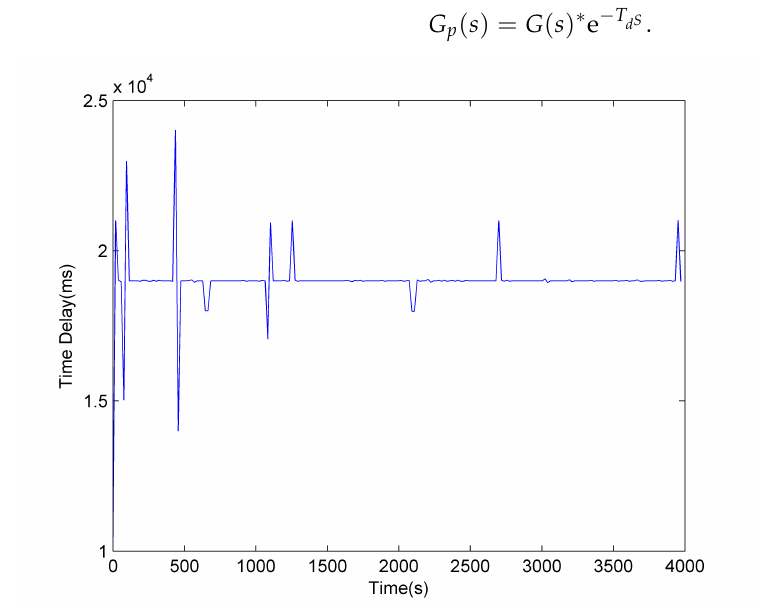
Figure 5. Network